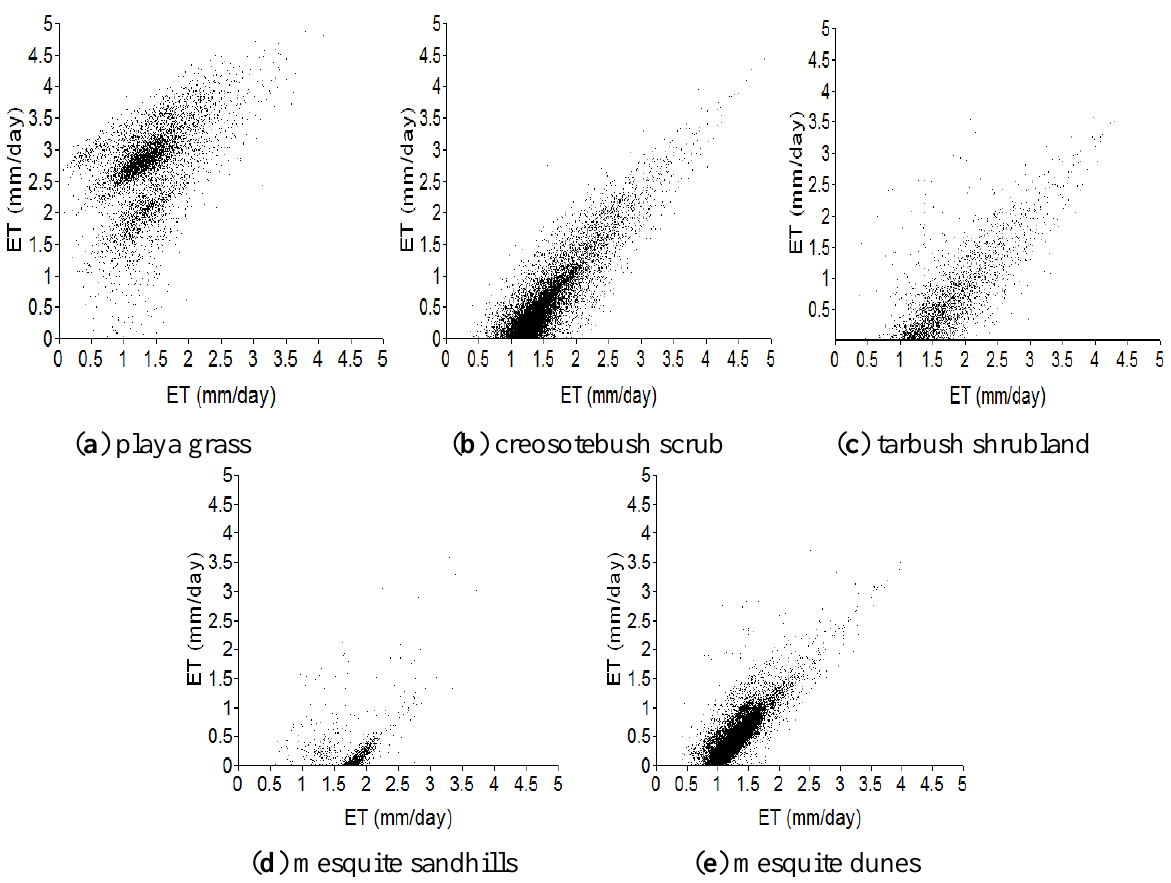
Figure 9. Scatterplots of ET single pixels values (mm/day) for (a) playa grassland, (b) creosotebush scrub, (c) tarbush shrubland, and (d,e) mesquite duneland for corrected model (y) and non-corrected